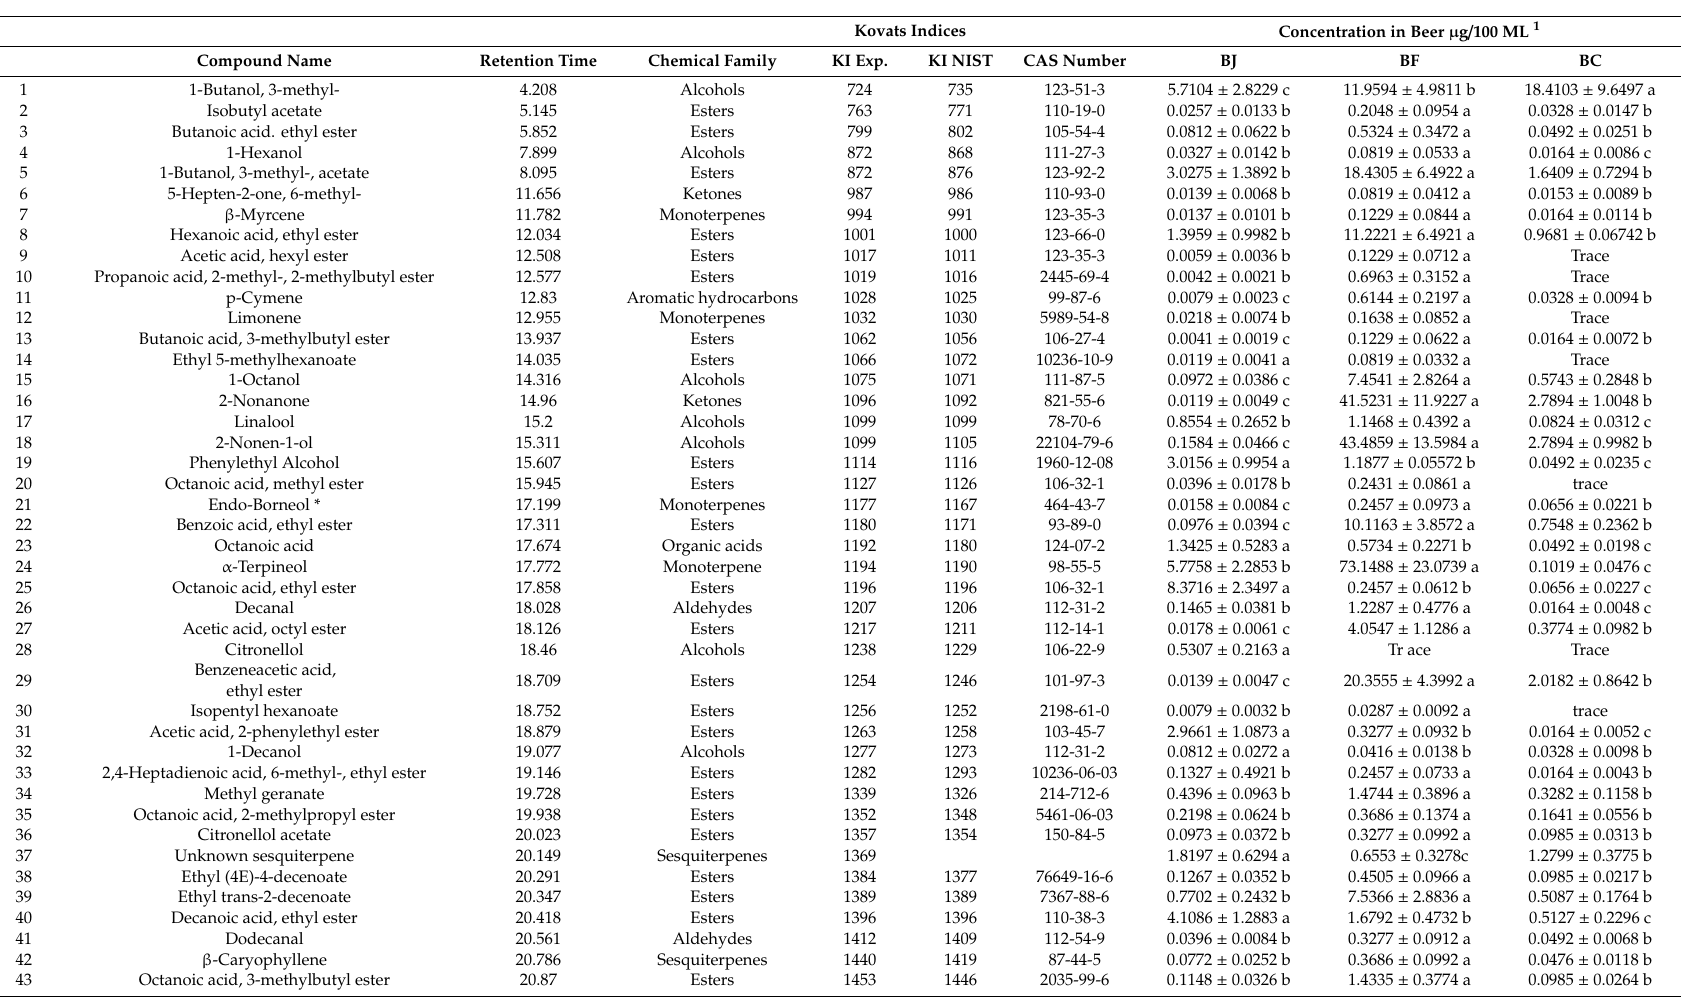
Table 3. Content of volatile compounds in tested